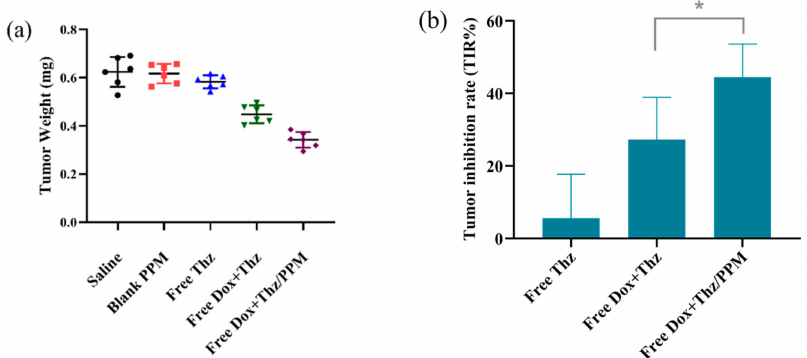
Figure 10. The tumor weight ( a ) and tumor inhibition rate (TIR%) ( b ) of xenograft tumor-bearing nude mice at the end of the test after intravenously-injected saline, blank PPM, Thz solution, Dox and Thz solution, and Dox solution and Thz / PPM ( n = 6). * p < 0.05.